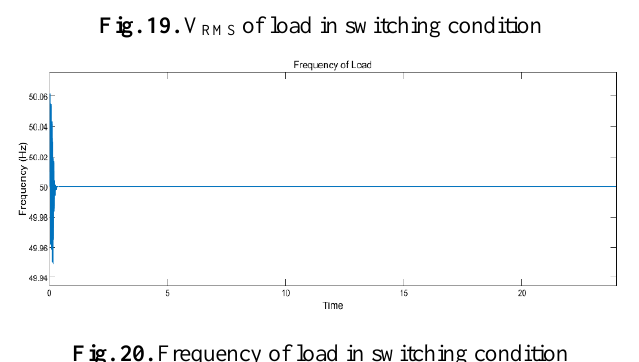
Fig. 20. Frequency of load in switching condition